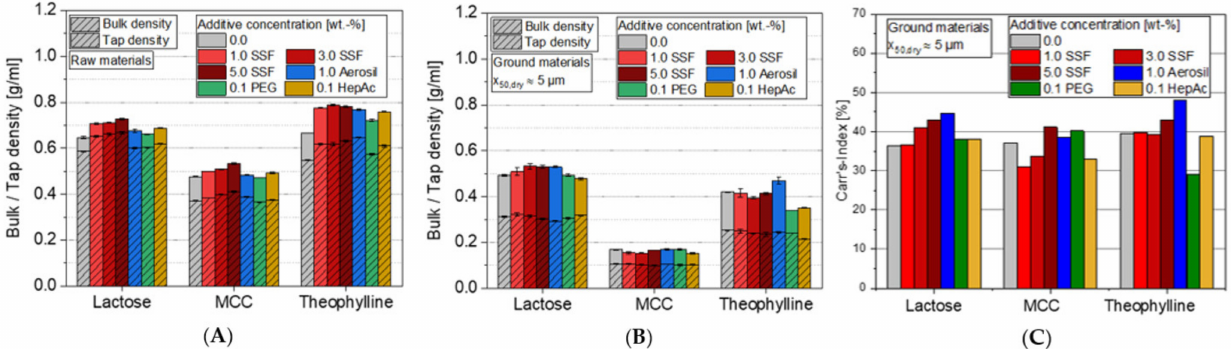
Figure 10. Impact of additive type and additive concentration on the bulk and tap density for ( A ) raw and ( B ) ground materials, as well as ( C ) Carr’s index for ground materials, n =